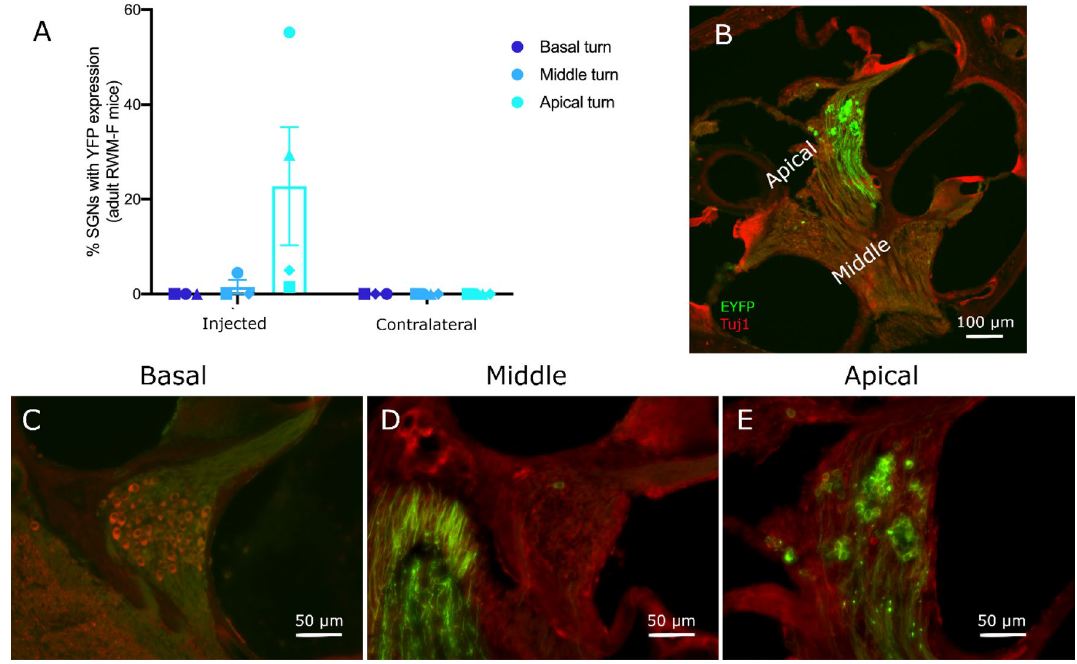
Figure 3. Expression of ChR2-H134R in cochlear SGNs following AAV-injection via the cochlear RWM of an adult C57BL/6 mouse with fenestration of the SCC (RWM-F). ( A ) The percentage of EYFP-expressing SGNs was highest in the apex but dropped dramatically by the middle turn and was not observed in the basal turn (n = 4; data excludes two mice in which there was no detectable ChR2-H134R-EYFP expression; error bars show the standard error of the mean). EYFP-expressing neurons were not observed in contralateral cochleae. ( B ) Section of an injected cochlea showing the middle and apical turns. Expression of ChR2-H134R-EYFP was observed in apical turn SGN cell bodies and their central and peripheral fibres. ( C-E ) Images of Rosenthal’s canal from the basal, middle and apical turn of an adult mouse injected via the RWM-F technique. Transduced cells were visualised via the EYFP reporter (green) and the neurons were counterstained with the Tuj1 antibody (red). The proportion of SGNs expressing ChR2-H134R-EYFP was high in the apical turn only. In the middles turn ( D ), EYFP-expressing central axons of SGNs from the apical turn are visible. Minor image processing (brightness) was applied equally to the EYFP channel across C-E for representation